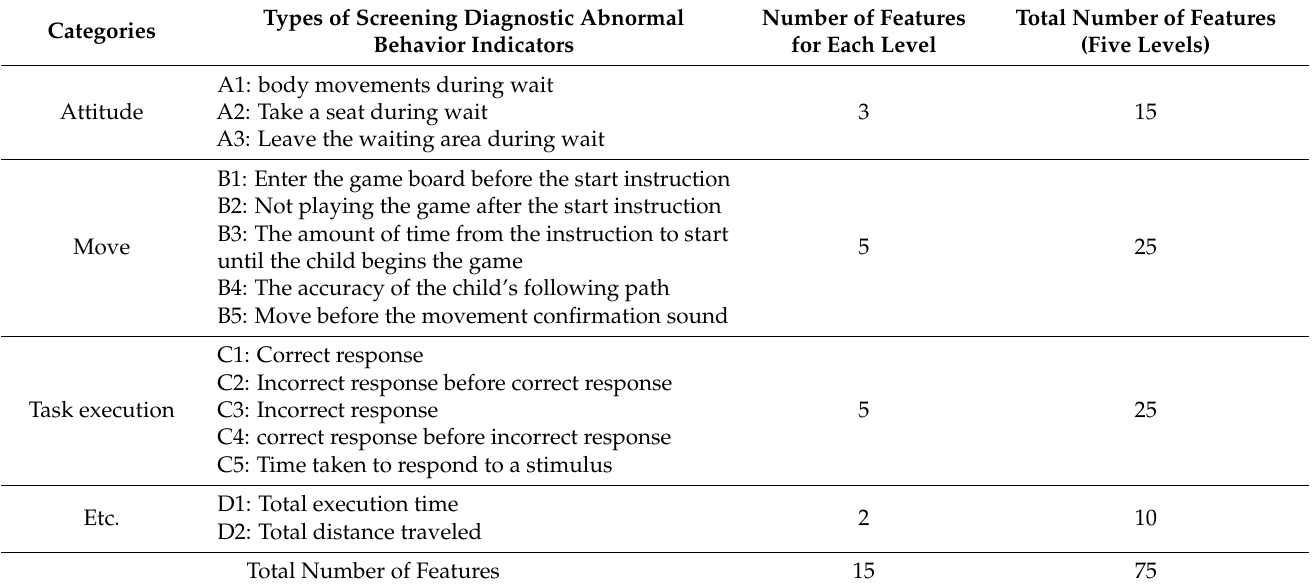
Table 2. Abnormal behavior indicators for screening of